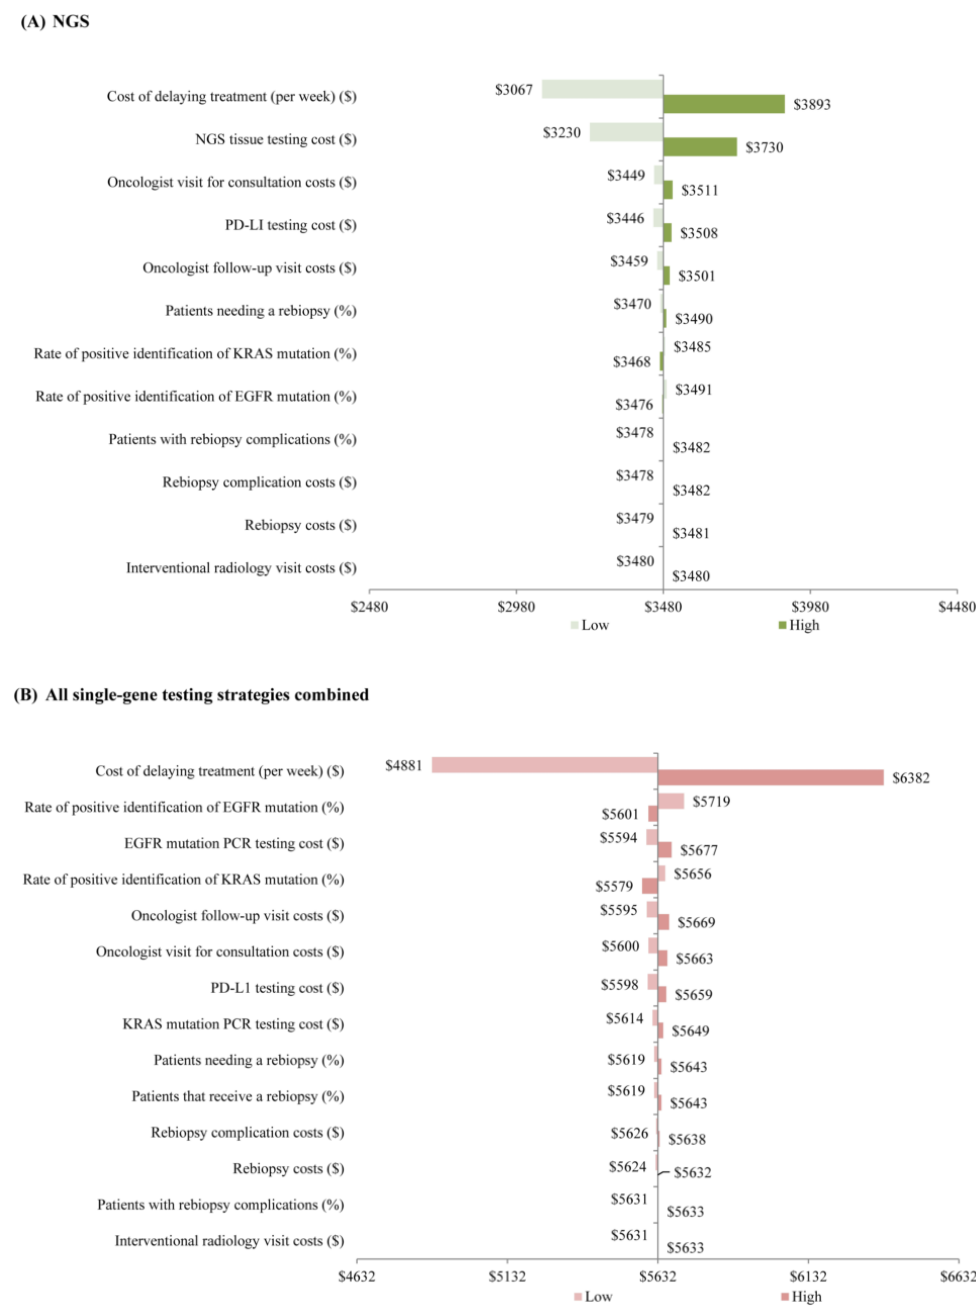
Figure 3. Sensitivity analysis ( A ) among patients undergoing NGS testing and ( B ) for all